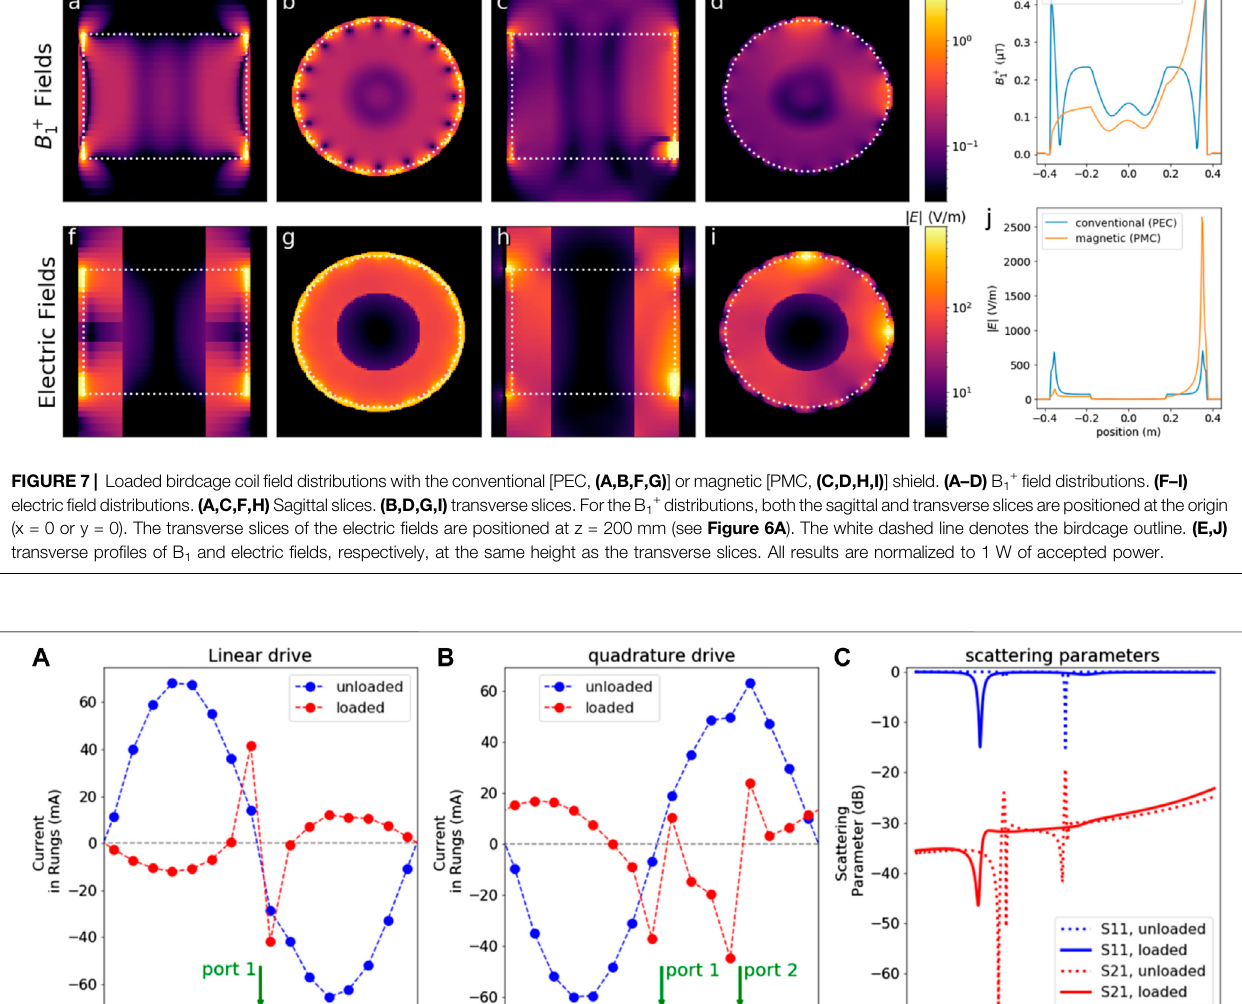
Frontiers in Physics |